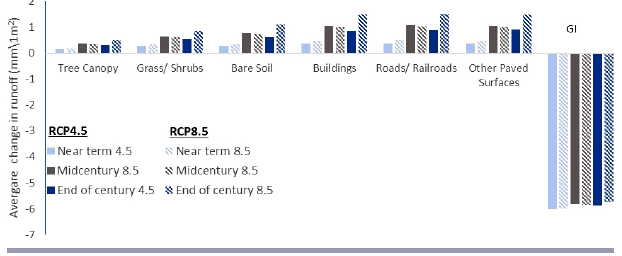
Fig. 2 . The average change in per-pixel runoff associated with each type of landcover, respective of time period and climate change